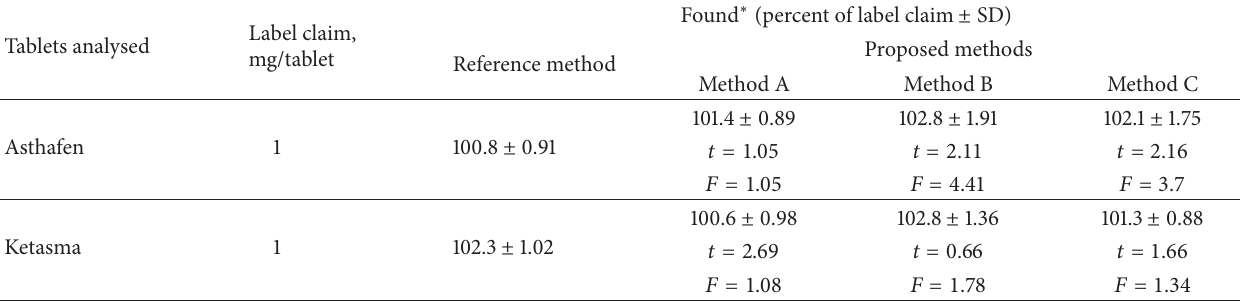
Table 5: Results of analysis of tablets by the proposed methods and statistical comparison with the reference method. Tablets